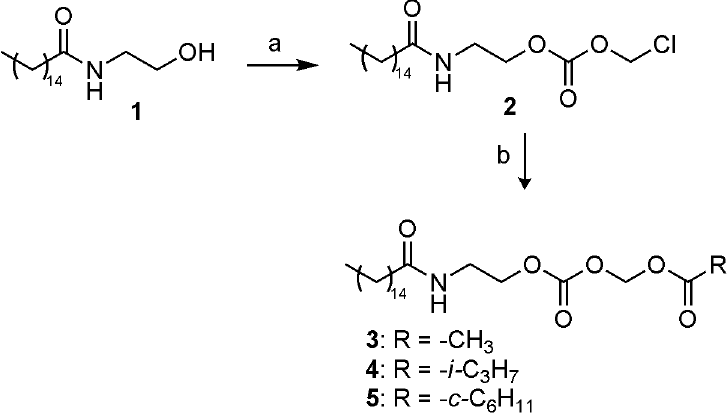
Fig 3. Synthesis of acyloxymethylcarbonates 3 – 5. Reagents and conditions: (a) chloromethyl chloroformate, pyridine, DCM, 0°C, 1 h; (b) RCOOCs, tetra -butyl ammonium iodide, acetonitrile, 80°C, 12